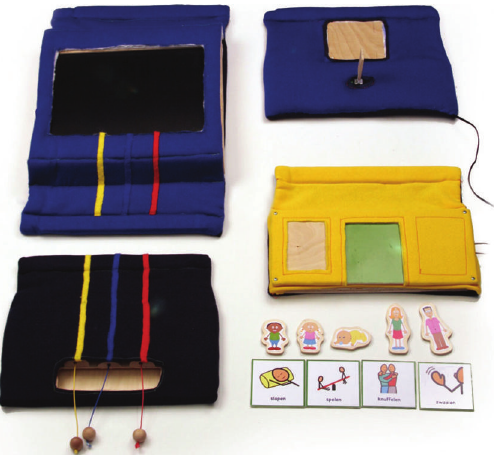
Figure 3: The KLEEd prototype, with clockwise from the top left: the console, the navigation mat, the combination mat, tagged input material, and the hide and seek mat.